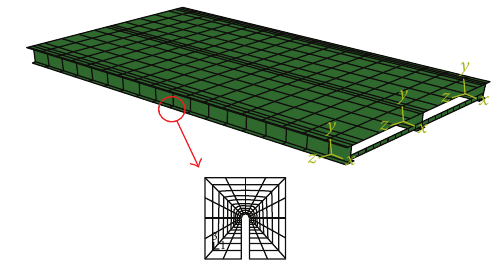
Figure 14: Finite element meshes in the crack tip